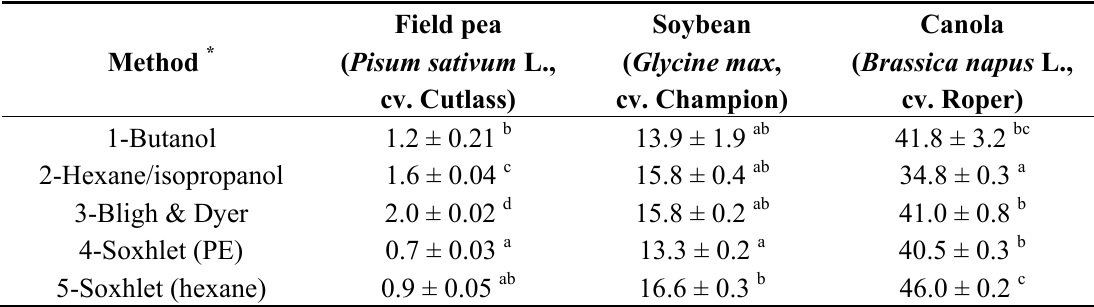
Table 1. Average lipid concentration (% dry mass) of field pea, soybean and canola seeds scored by using different extraction